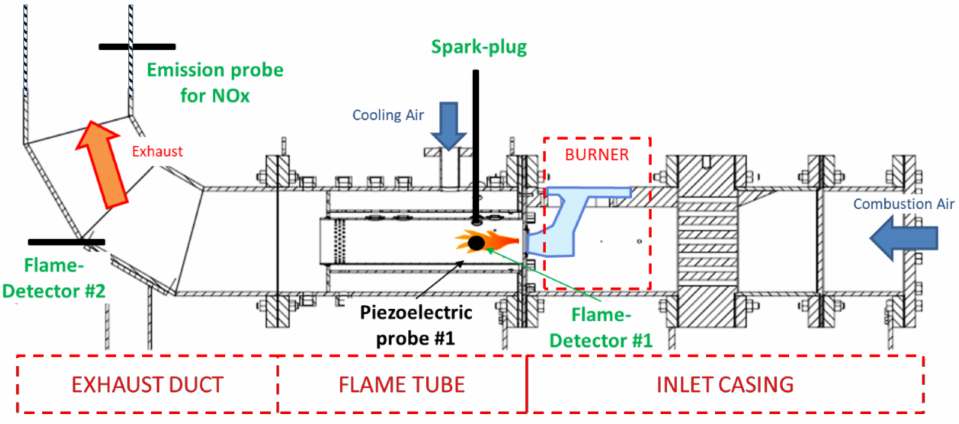
Figure 14. Test rig